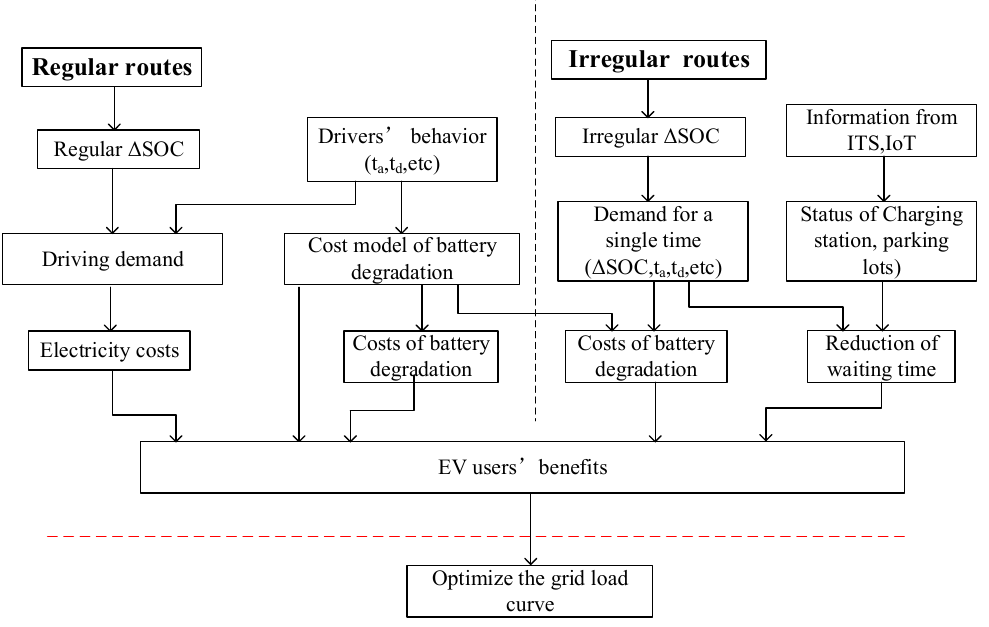
Figure 1. Overall structure of the optimal planning method.